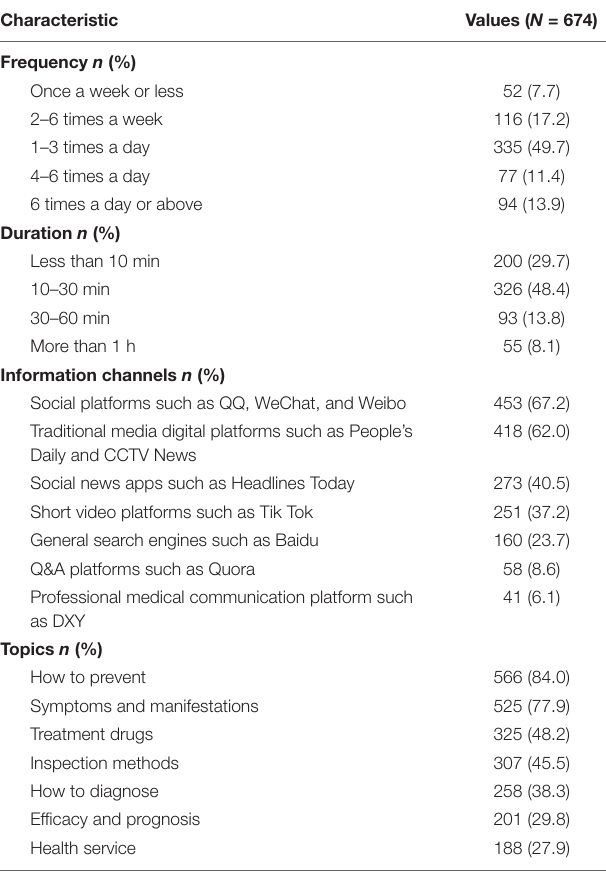
TABLE 3 | Characteristics of COVID-19-related online information seeking